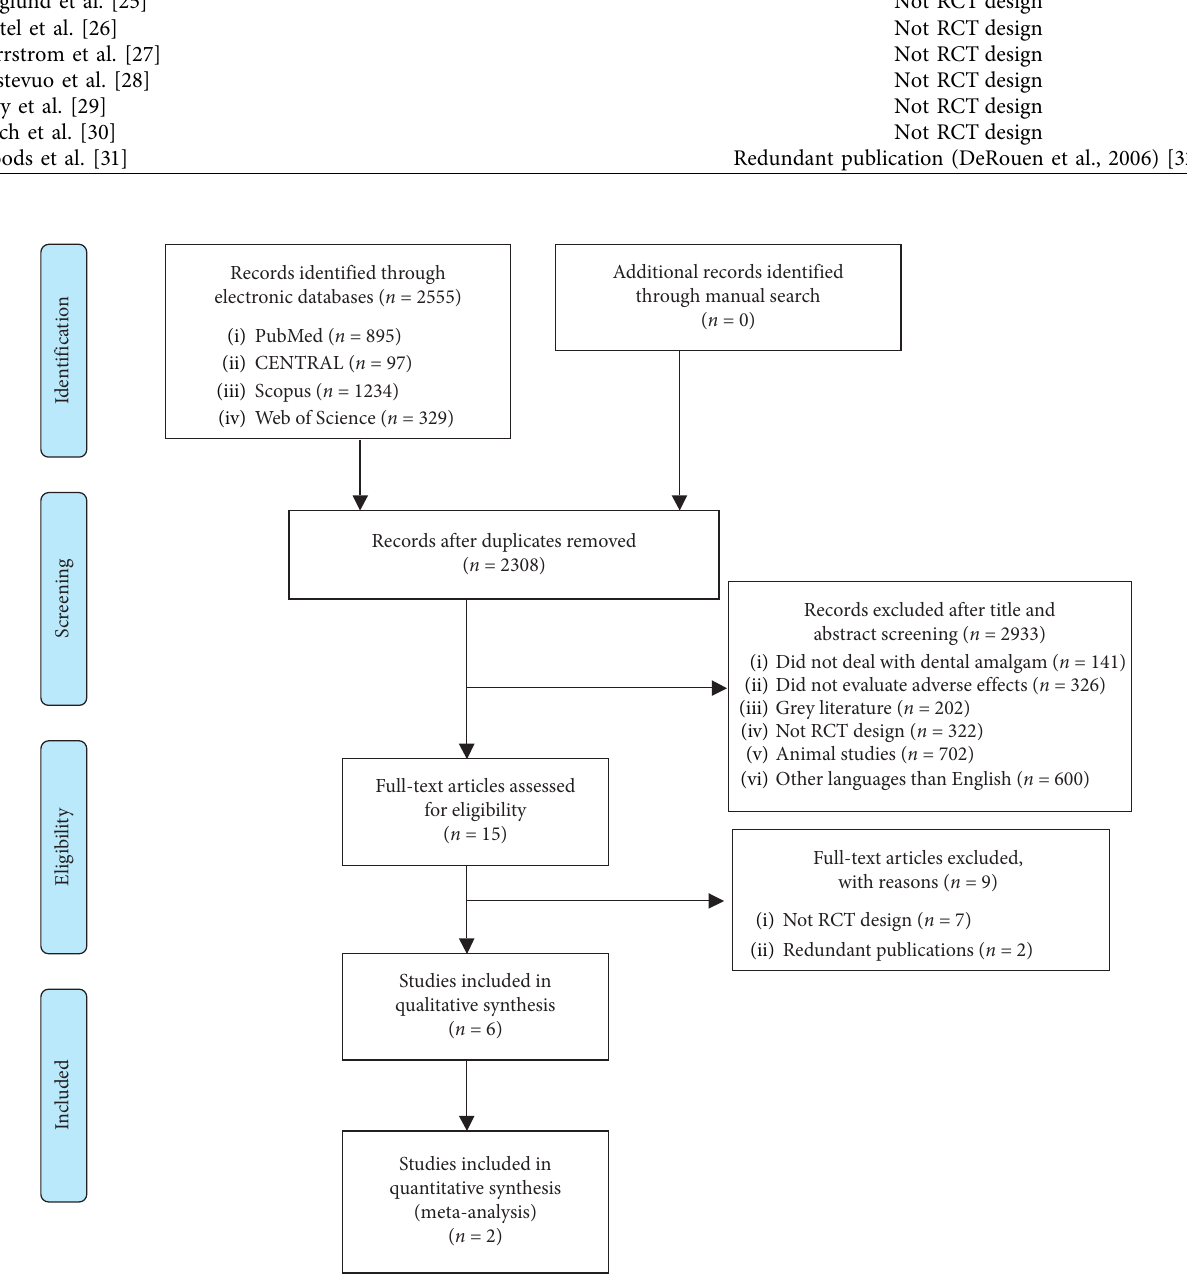
Figure 1: Flow chart of the search